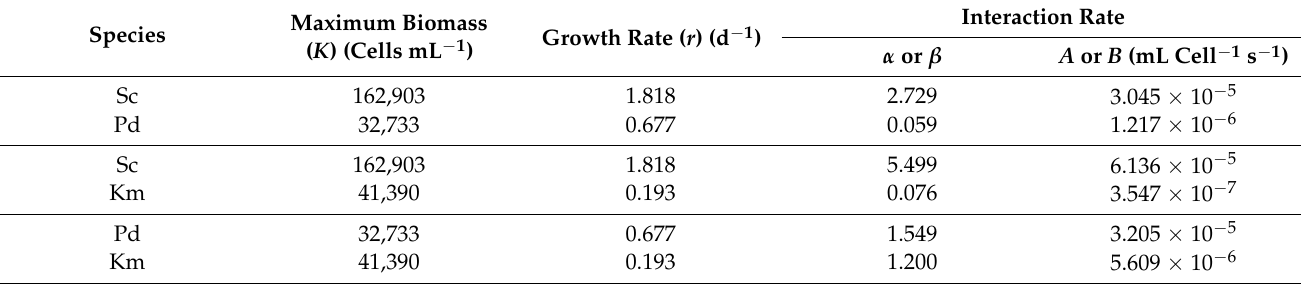
Table 2. Estimates of model parameters for the mono- and bi-algal cultures of S. costatum , P. dong- haiense , and K. mikimotoi under P-deficient conditions.